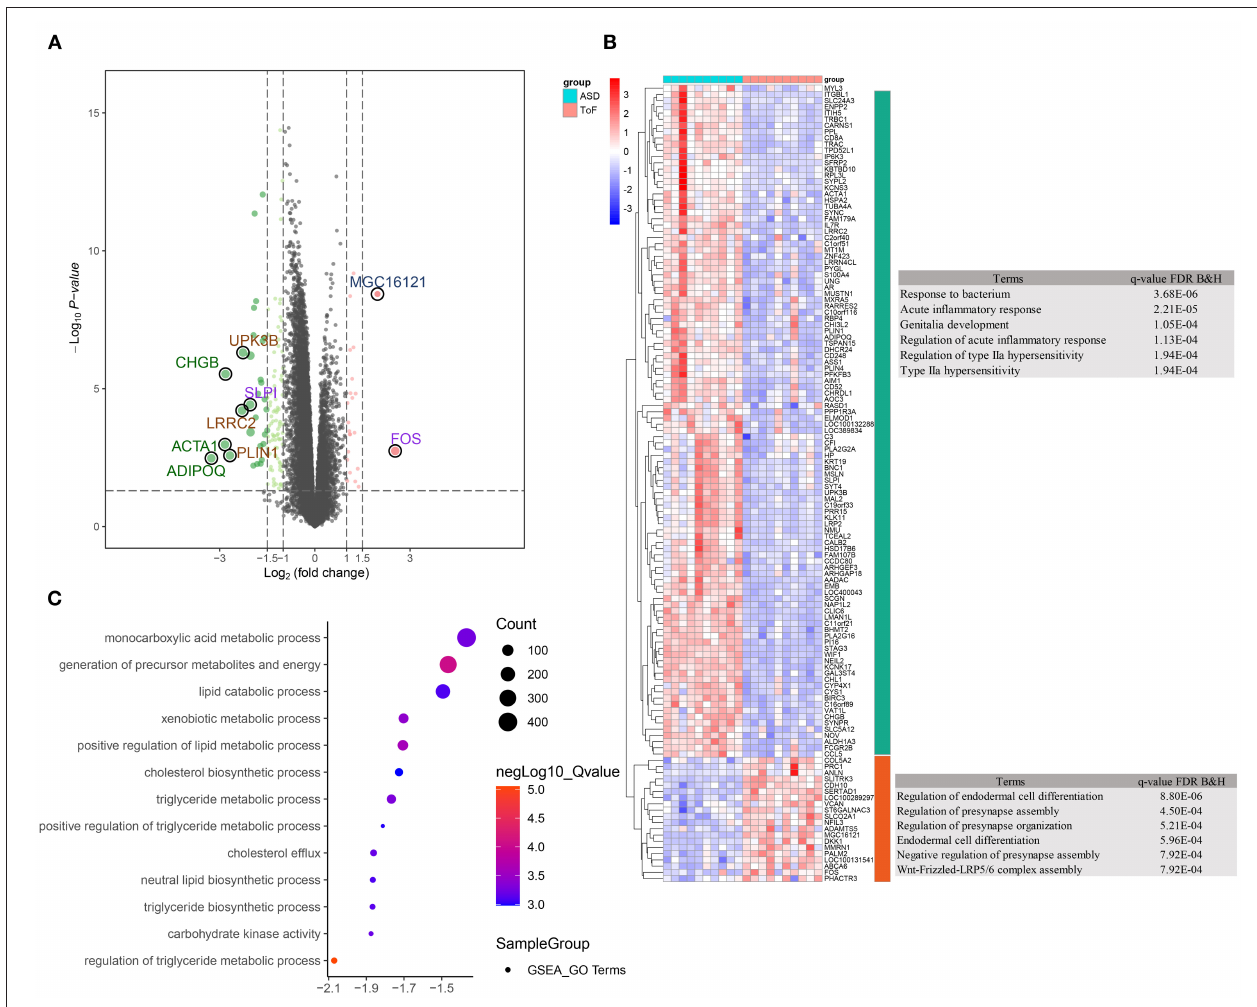
FIGURE 2 | Differentially expressed gene (DEG) identification and functional enrichment analysis. (A) Volcano plot showing DEG distribution. (B) Clustering heatmap and biological analysis presenting the biological function of up- and downregulated DEGs. (C) Biological function terms based on gene ontology were calculated by the GSEA algorithm in response to the comparison between ToF and ASD RA